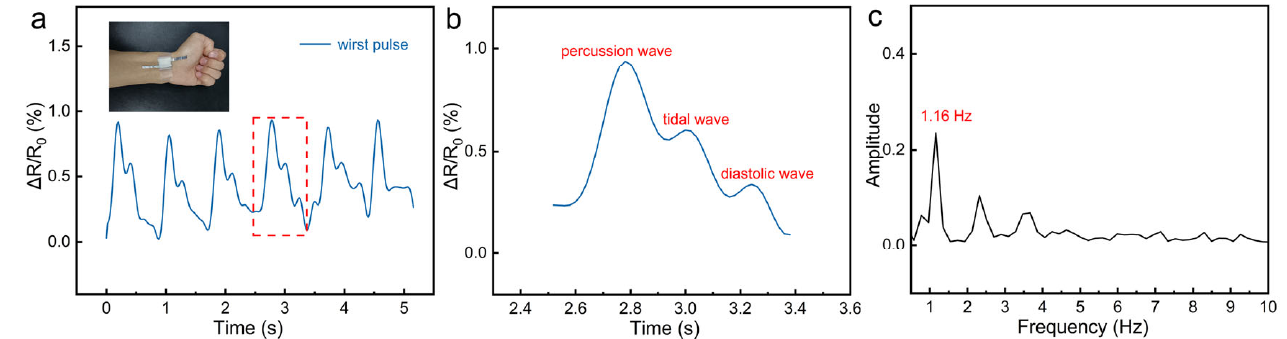
Figure 7. ( a ) Monitoring of the wrist pulse based on the fabricated piezoresistive pressure sensor. The inset is a photo of the wrist of the tester with the pressure sensor. ( b ) Magnified view of a single wrist pulse waveform. ( c ) The Fast Fourier transform of waves of the wrist pulse.